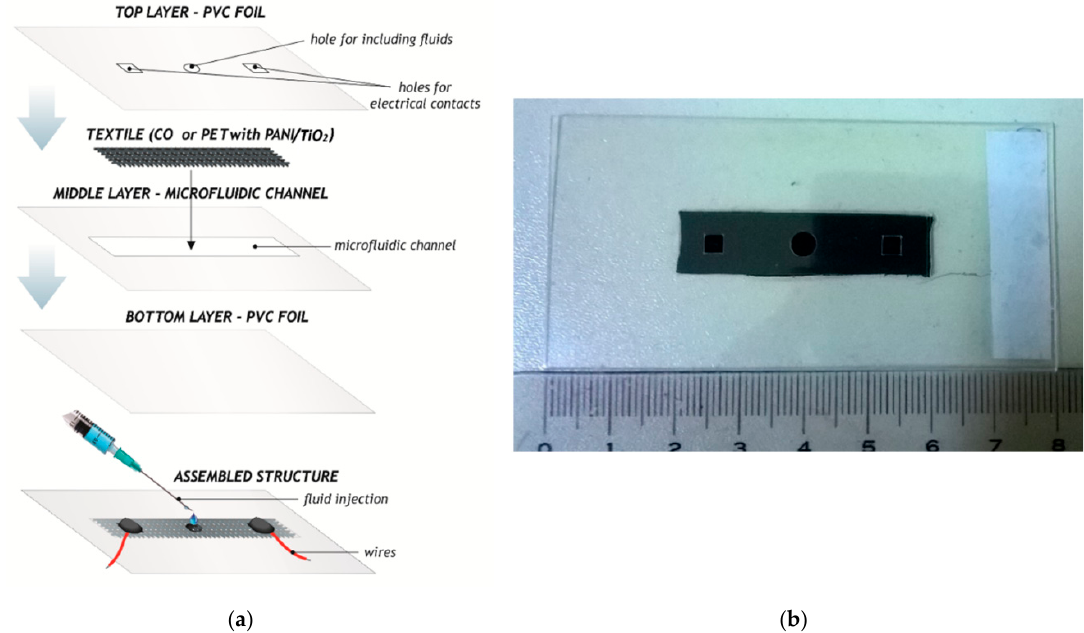
Figure 1. ( a ) Design of the separate layers; ( b ) the manufactured textile-based microfluidic